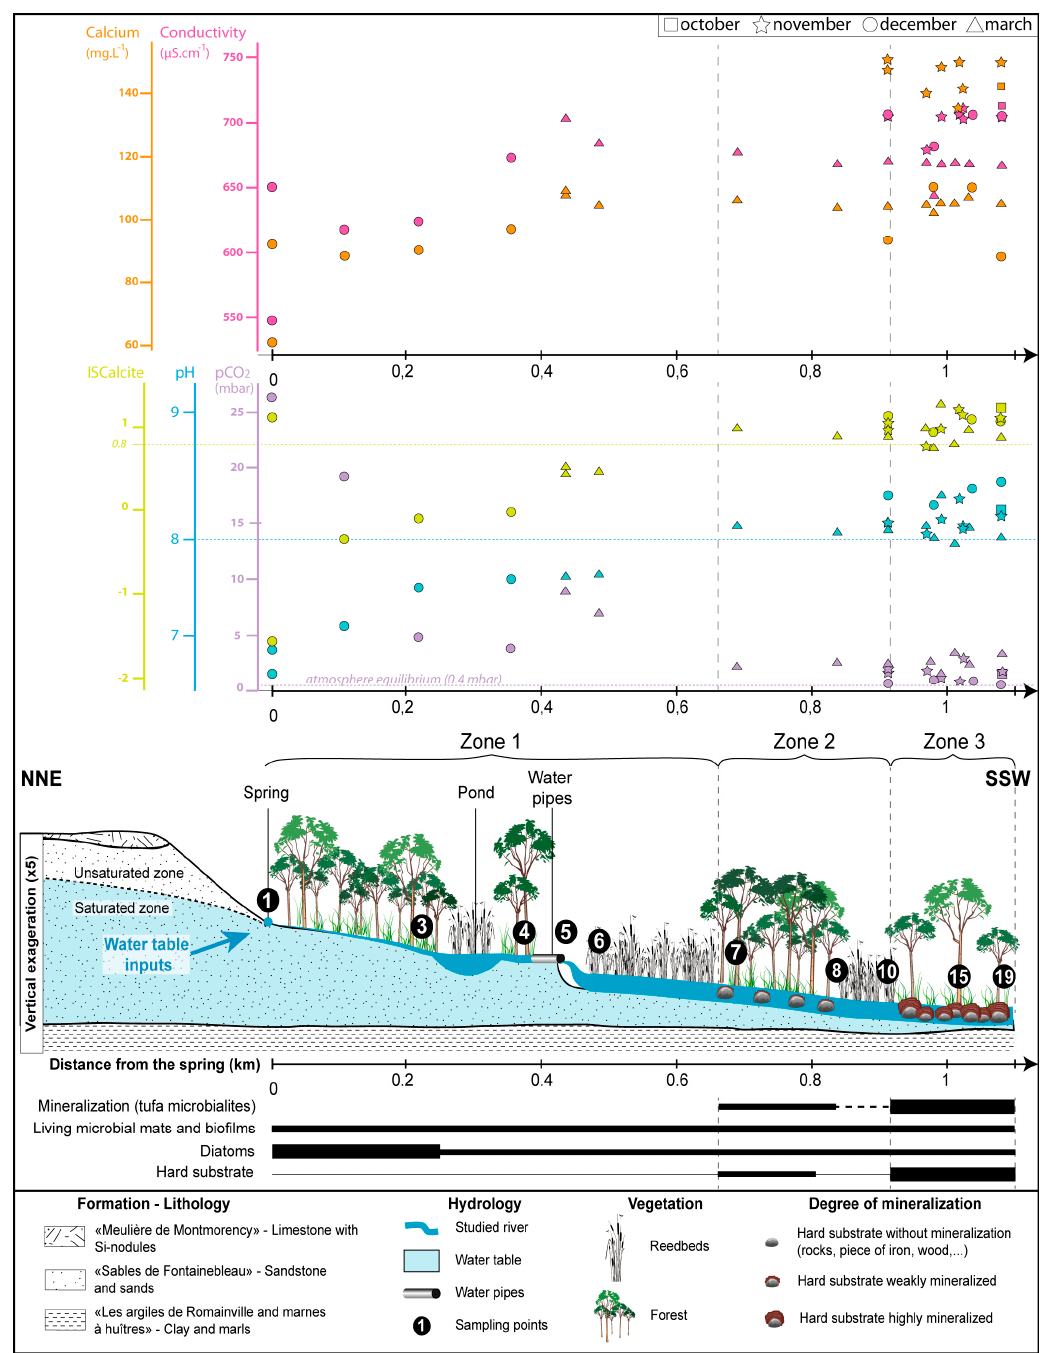
Figure 2. 2D profile of stream showing main hydrochemical characteristics (IS calc ; pH; pCO 2 ; calcium